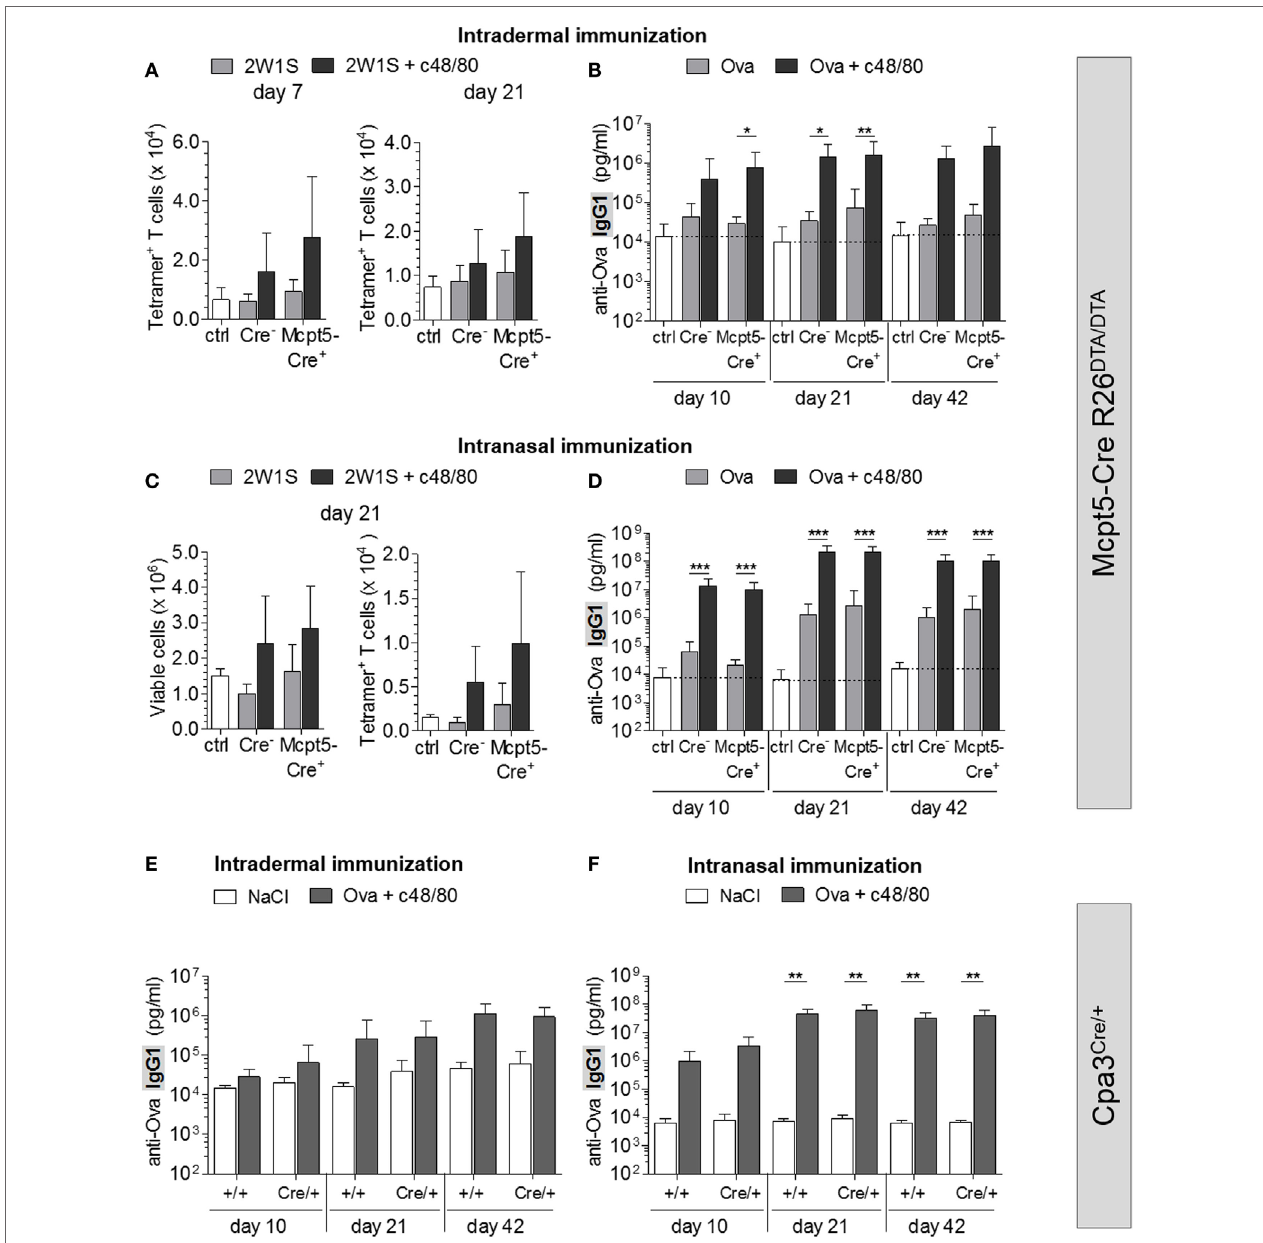
FigUre 5 | Mast cells (MCs) are dispensable for c48/80-induced antigen-specific T cell and antibody responses. (a,B) Cre -negative and Mcpt5-Cre + R26 DTA/DTA mice were intradermally injected with antigen (2W1S or Ova) alone, with antigen plus c48/80 or with saline. (a) Total numbers of 2W1S-specific CD4 + T cells identified by tetramer staining in inguinal LNs 7 (saline n = 7; 2W1S alone n = 5 both groups; 2W1S plus c48/80 Cre + n = 11, Cre − n = 10) or 21 days after immunization (saline n = 4; 2W1S alone n = 5 both groups; 2W1S plus c48/80 n = 7 both groups). (B) Quantification of anti-Ova IgG1 by ELISA in the serum of saline treated Cre -negative controls ( n = 12) and mice immunized i.d. with Ova alone or with Ova plus c48/80 (Ova alone n = 10 both groups; Ova plus c48/80 Cre + n = 9, Cre − n = 10). Data from two independent experiments with similar results. (c,D) Antigen alone (2W1S or Ova) or antigen plus c48/80 was administered into both nostrils of Cre -negative and Mcpt5-Cre + R26 DTA/DTA mice. (c) Total cellularity and 2W1S-specific (tetramer + ) CD4 + T cells were quantified flow cytometrically in draining mandibular LNs 21 days after immunization (saline n = 5; 2W1S alone Cre + n = 6, Cre − n = 5; 2W1S plus c48/80 n = 6 both groups). (D) Quantification of anti-Ova IgG1 by ELISA in the serum of saline treated Cre -negative controls ( n = 11) and mice immunized intranasally with Ova alone or with Ova plus c48/80 (Ova alone Cre + n = 13, Cre − n = 12; Ova plus c48/80 n = 13 both groups). Data from three independent experiments that yielded similar results. (e) Quantification of anti-Ova IgG1 by ELISA in the serum of saline-treated control animals ( Cpa3 + / + n = 4, Cpa3 Cre/ + n = 3) and MC-deficient Cpa3 Cre/ + mice and Cpa3 + / + littermates immunized intradermally with Ova plus c48/80 ( Cpa3 + / + n = 7, Cpa3 Cre/ + n = 6). A single experiment was performed. (F) Quantification of anti-Ova IgG1 by ELISA in the serum of saline treated controls ( Cpa3 + / + n = 6, Cpa3 Cre/ + n = 3) and mice immunized intranasally with Ova plus c48/80 ( Cpa3 + / + n = 9, Cpa3 Cre/ + n = 6). A single experiment was performed. In all cases, means ± SD are shown, and statistical analysis was performed using one-way ANOVA and Bonferroni’s multiple comparison